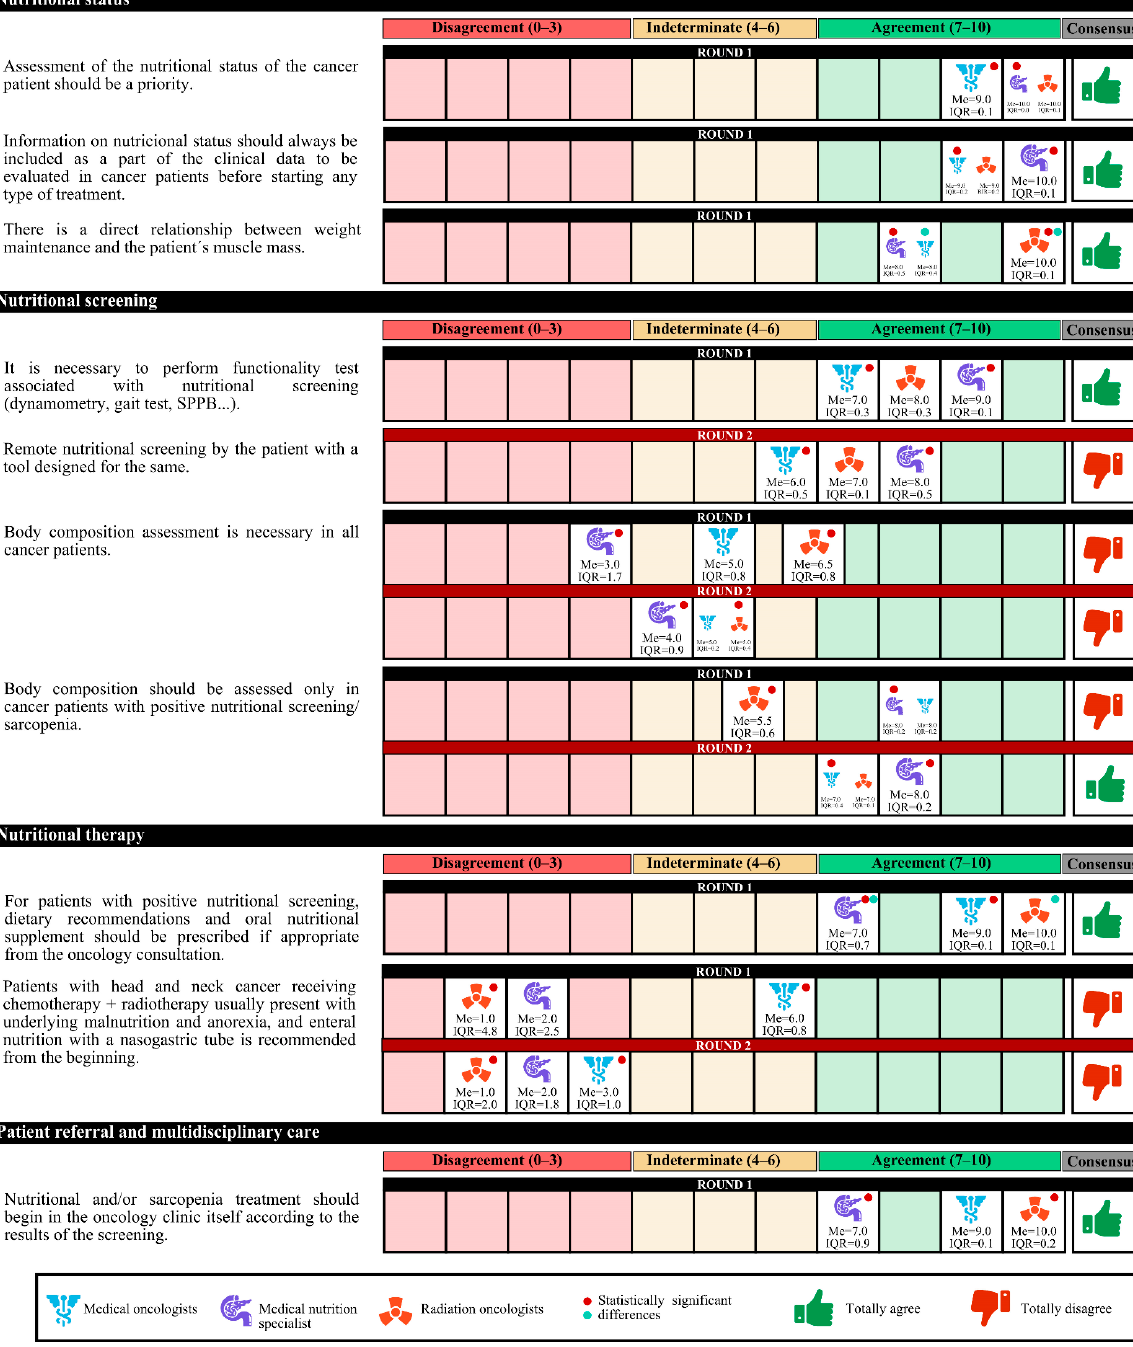
Figure 11. Responses with significant differences among the different medical specialties. All tests had a p value < 0.05. IQR, interquartile range; Me, median. SPPB, short physical performance battery.